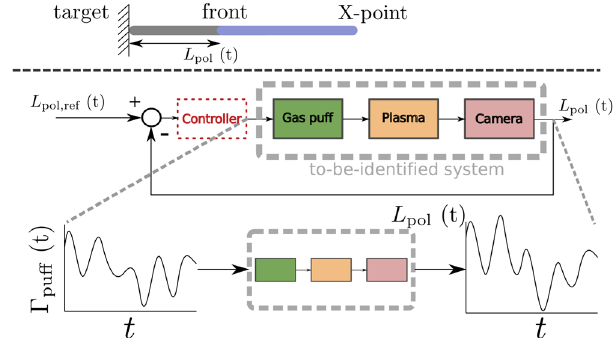
Fig. 4 Schematic representation of system identi fi cation and feedback controller. A simpli fi ed, one-dimensional cartoon of the dynamic